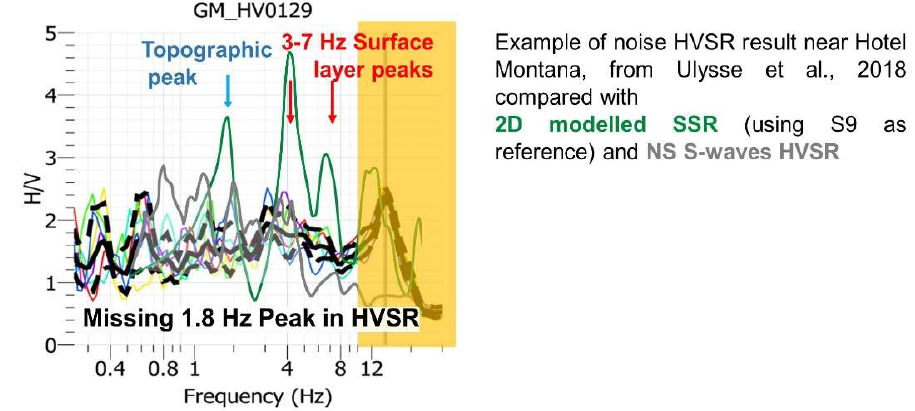
Figure 9. Simulated surface layer model SSR for the equivalent HM site computed with respect to S9 receiver (representing the Delmas 60 site, see green curve) compared with measured NS S-waves HVSR (grey curve) and the noise HVSR presented by [3].